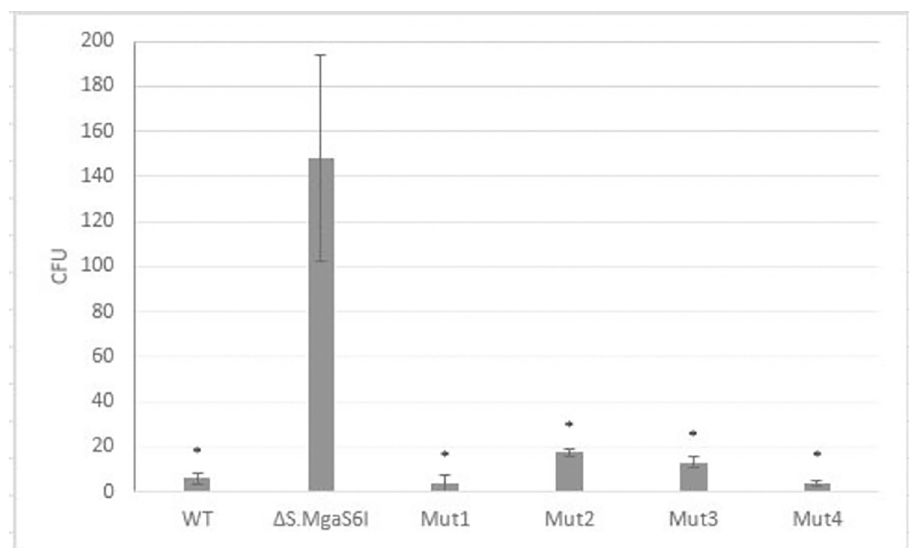
Fig 7. The efficiency of camR insertion into wild-type M . gallisepticum , Δ S.MgaS6I strain, and four strains with tetM insertion in various intergenic regions. CFUs of strains with significant difference, as compared to the CFU of Δ S.MgaS6I strain (Student’s t -test, P < 0.05), have been indicated using asterisks.